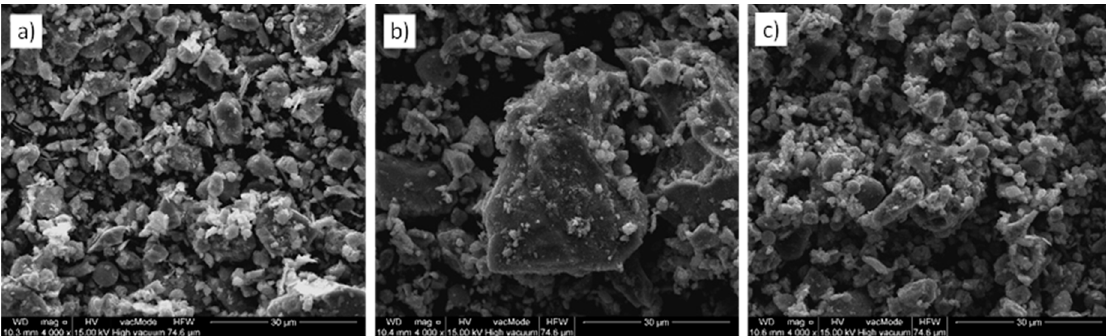
Figure 1. Microscopic images of rock dust: ( a ) limestone, ( b ) marble, ( c ) basalt.